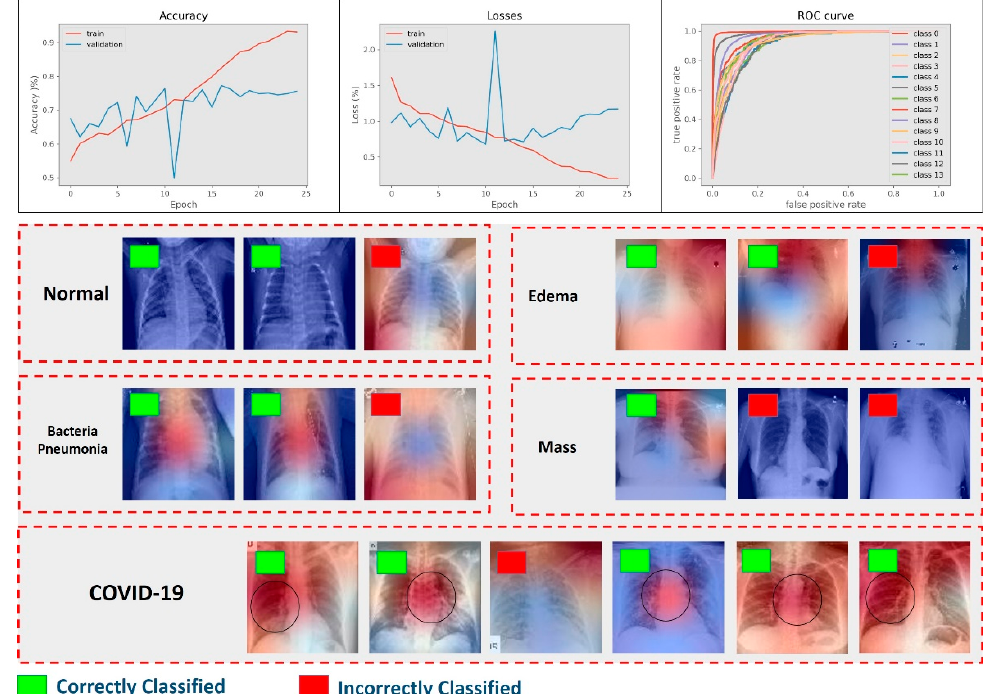
Figure 3. Visualized results for the multiclass classification. Train-validation accuracy and loss over the training epochs and AUC scores for the classes are presented in the top graph. Selected output images of the Grad-CAM implementation are visualized. Each dashed-line box presents a true class, while the green and red boxes distinguish between correctly classified samples and mistakes, re- spectively.